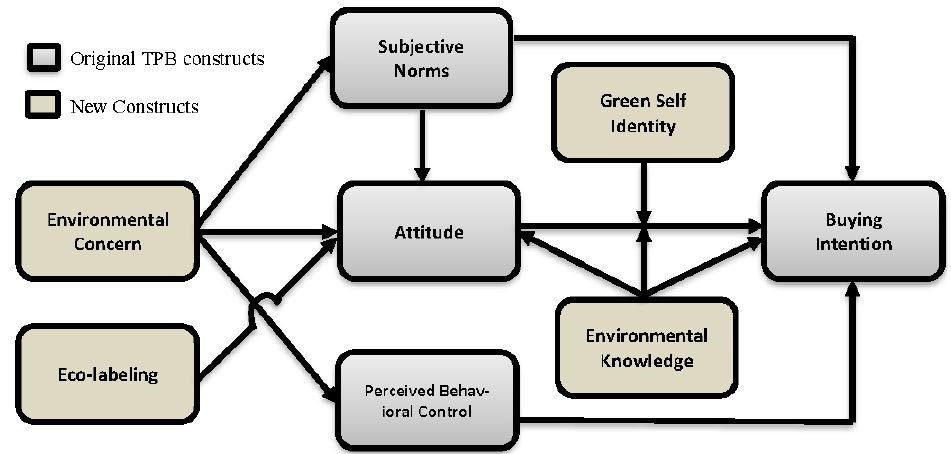
Figure 1. Conceptual Framework [Source: Authors compilation].